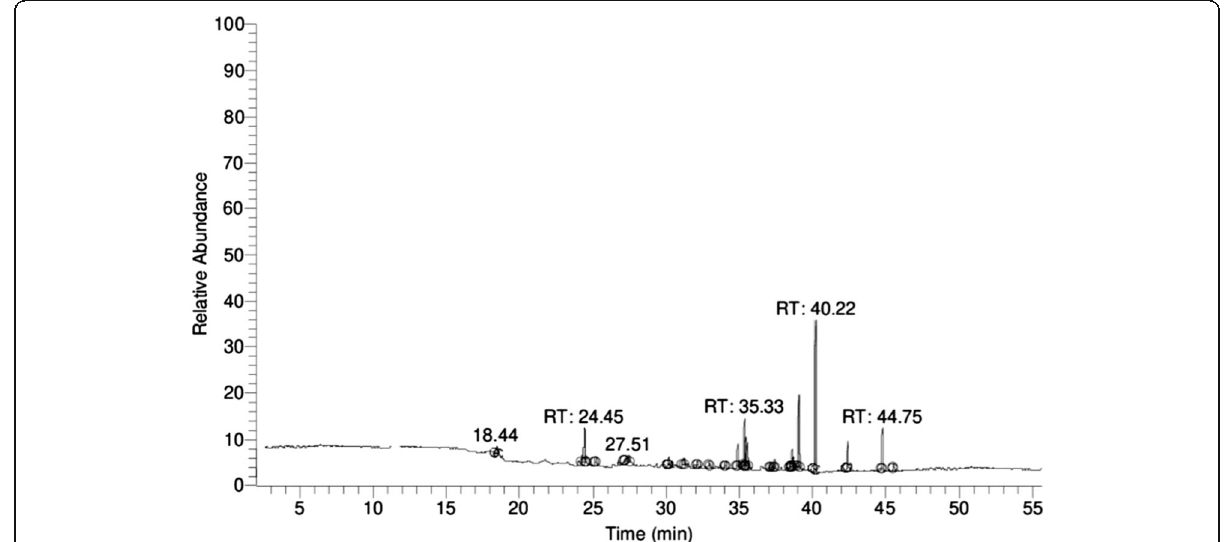
Fig. 4 Histogram showing GC – MS fractionation of ethyl acetate extract of S . actuosus (SCF20), (the most suppressive actinomycetes for PVY NTN